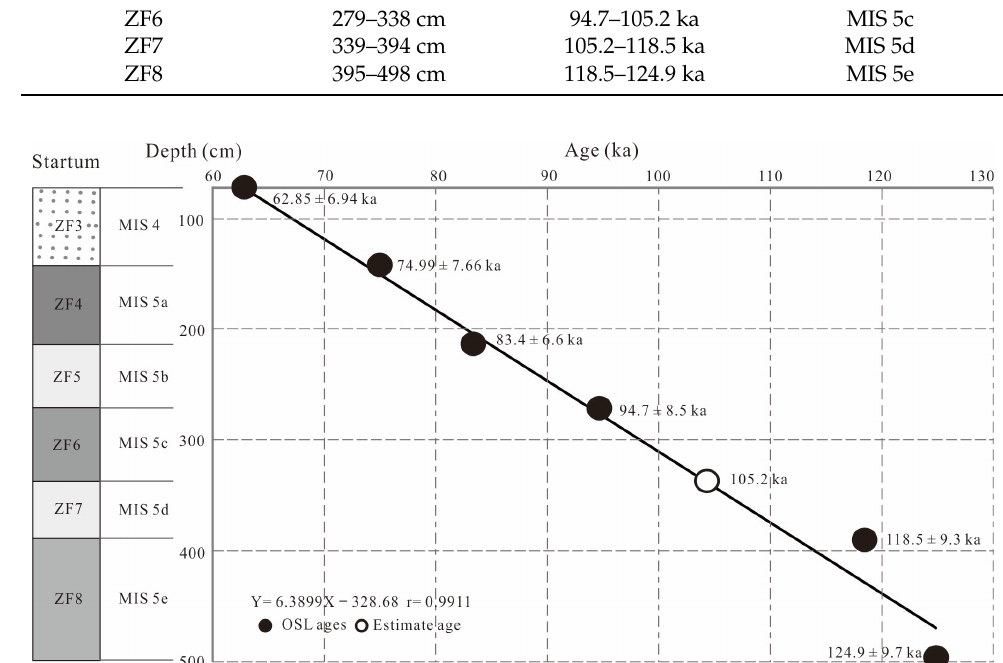
Figure 2. Stratigraphic sequence and age ‒ depth relationship of the ZFS during MIS 5 period.